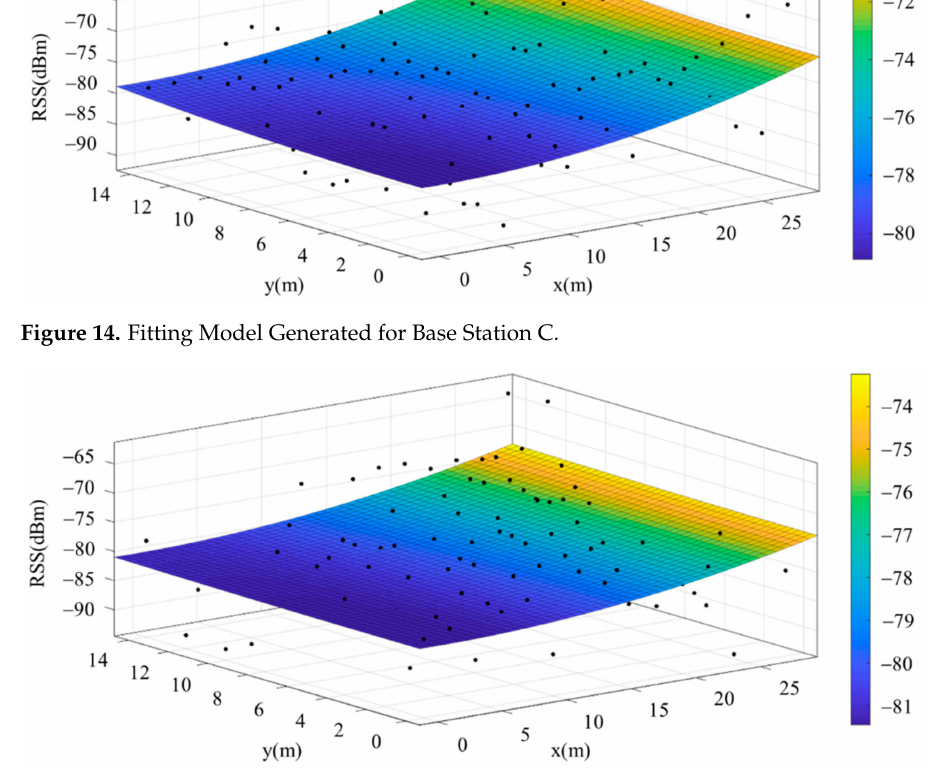
Figure 15. Fitting Model Generated for Base Station D. Table 2. Individual Fitting Model Equations for the Different Base